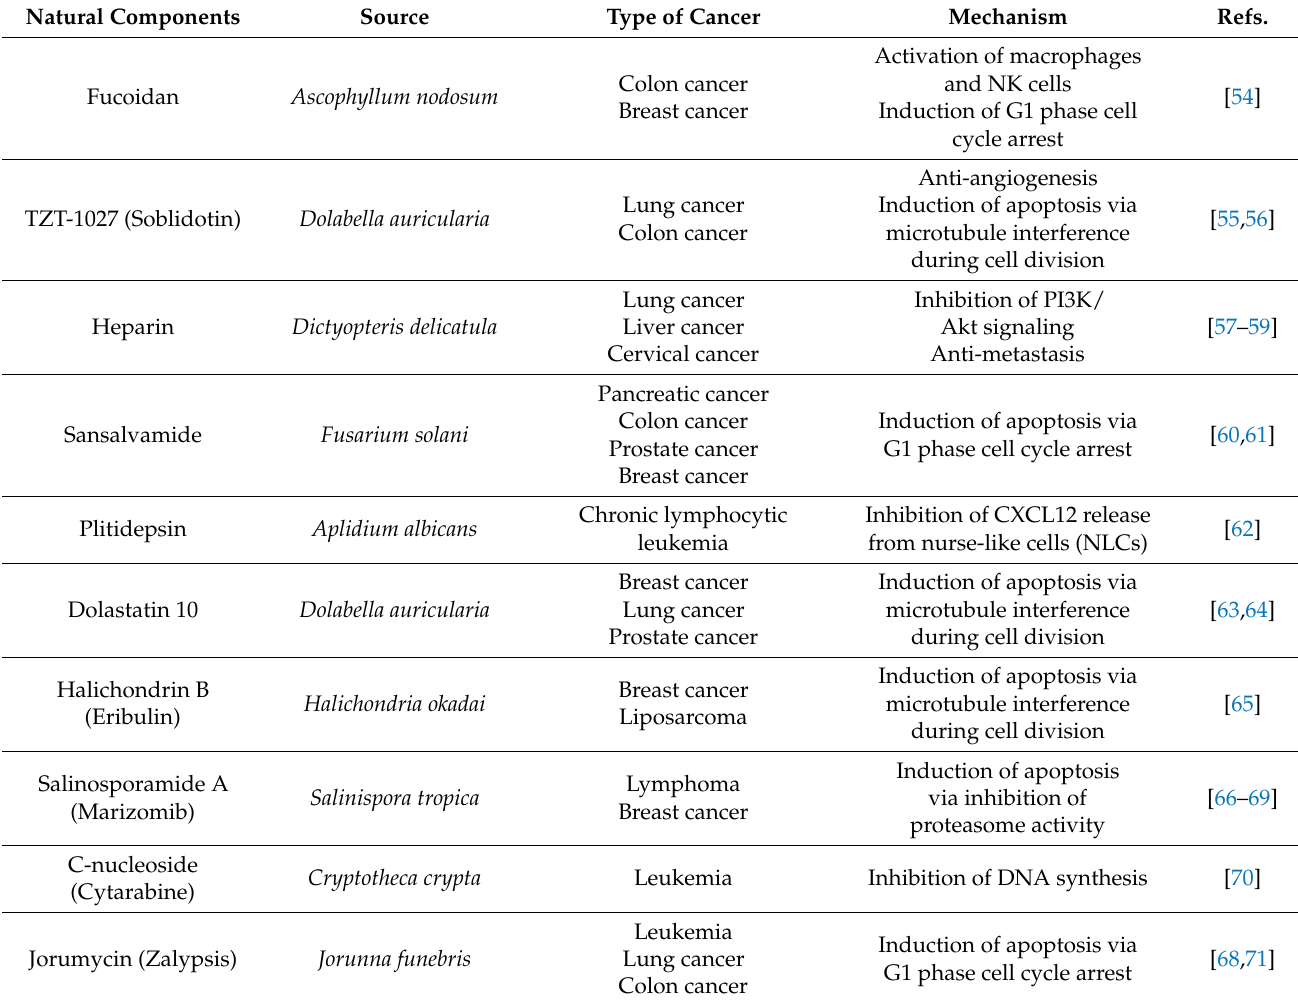
Table 2. The anticancer effects of representative marine natural